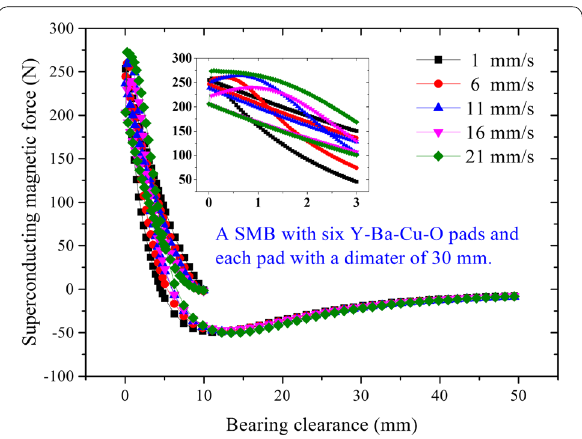
Figure 12 Superconducting magnetic force of an axial-type